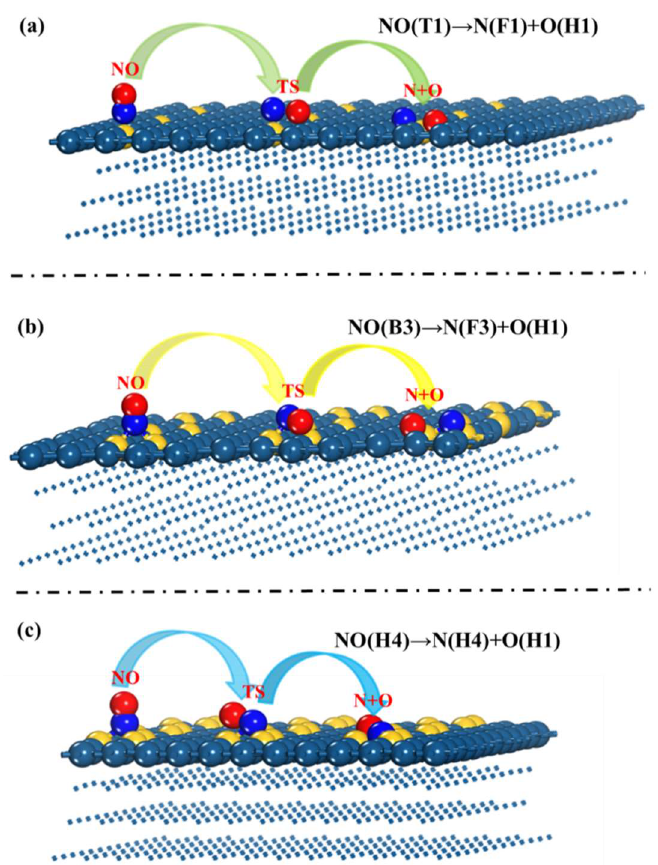
Figure 5. Structural diagram of NO decomposition on ( a ) Au single /Pt(111), ( b ) Au dimer /Pt(111), and ( c ) Au trimer /Pt(111) surfaces.